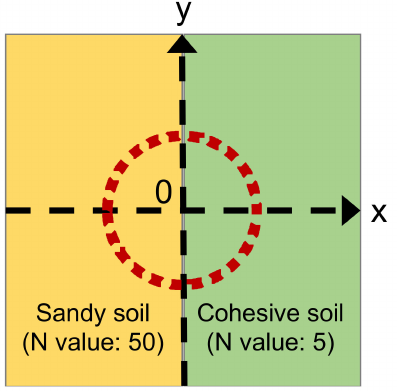
Figure 6. Top view of installing position of newly built pile foundation.